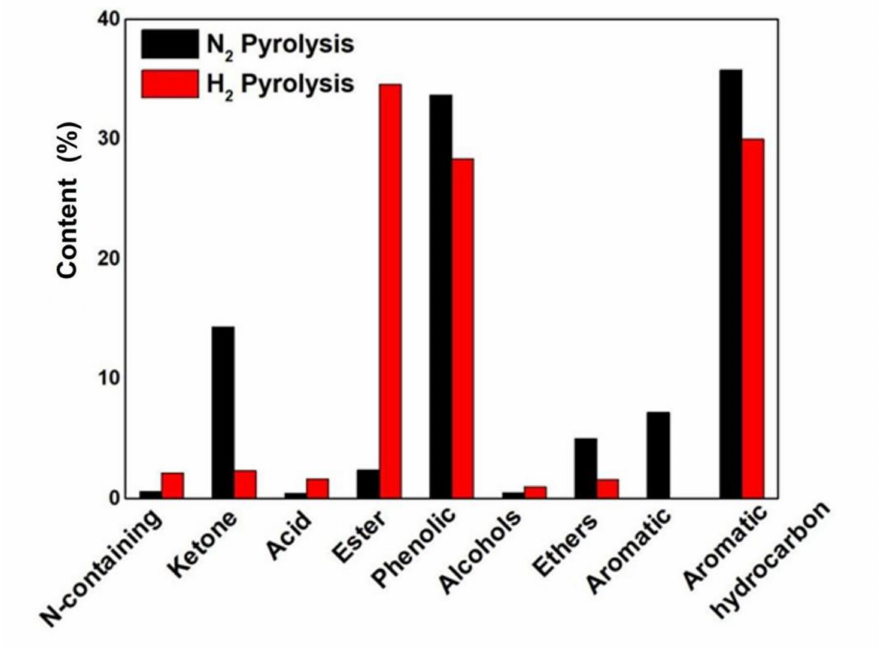
Figure 7. Comparative analysis of components of pyrolysis bio-oil under different